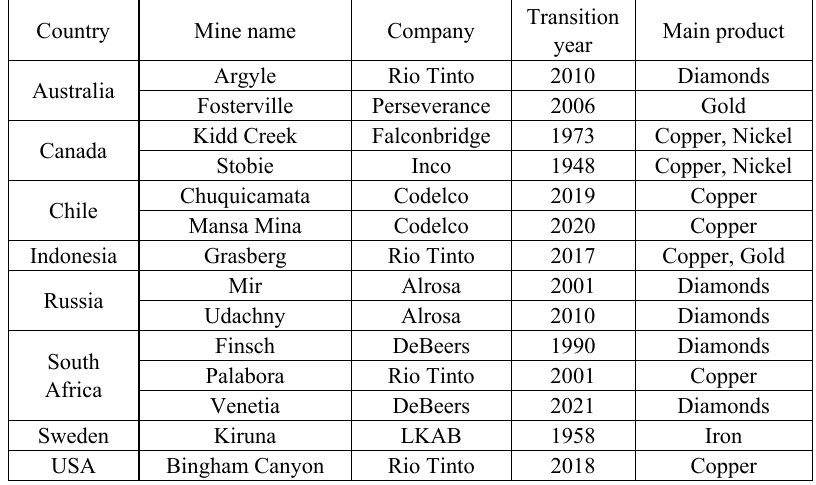
Table 1. Overview of major historical and future OP-UG transitions for ore body mining (modified after Visser